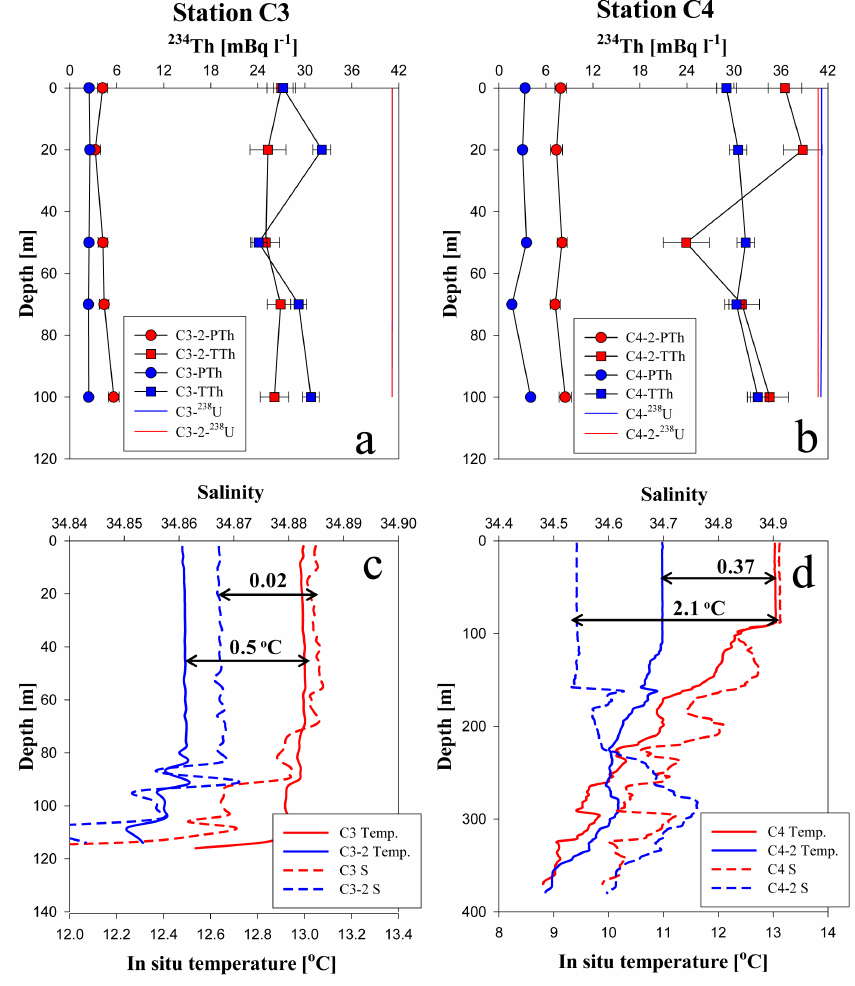
Fig. 7. (a) and (b) Vertical distributions of particulate and total 234 Th during the two visits to stations C3 and C4, with 16 days between C3 (26 May) and C3-2 (11 June) and 12 days between C4 (26 May) and C4-2 (7 June). (c) and (d) Vertical distributions of temperature and salinity at C3 and